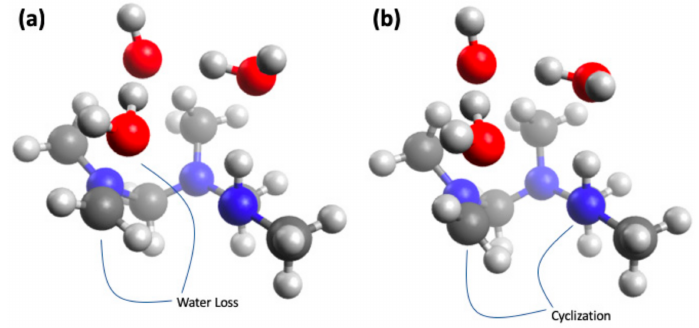
Figure 4. Key structure for the metal-free mechanism. ( a ) [L-M] rate determining step and ( b ) second cyclization transition state [M-N].